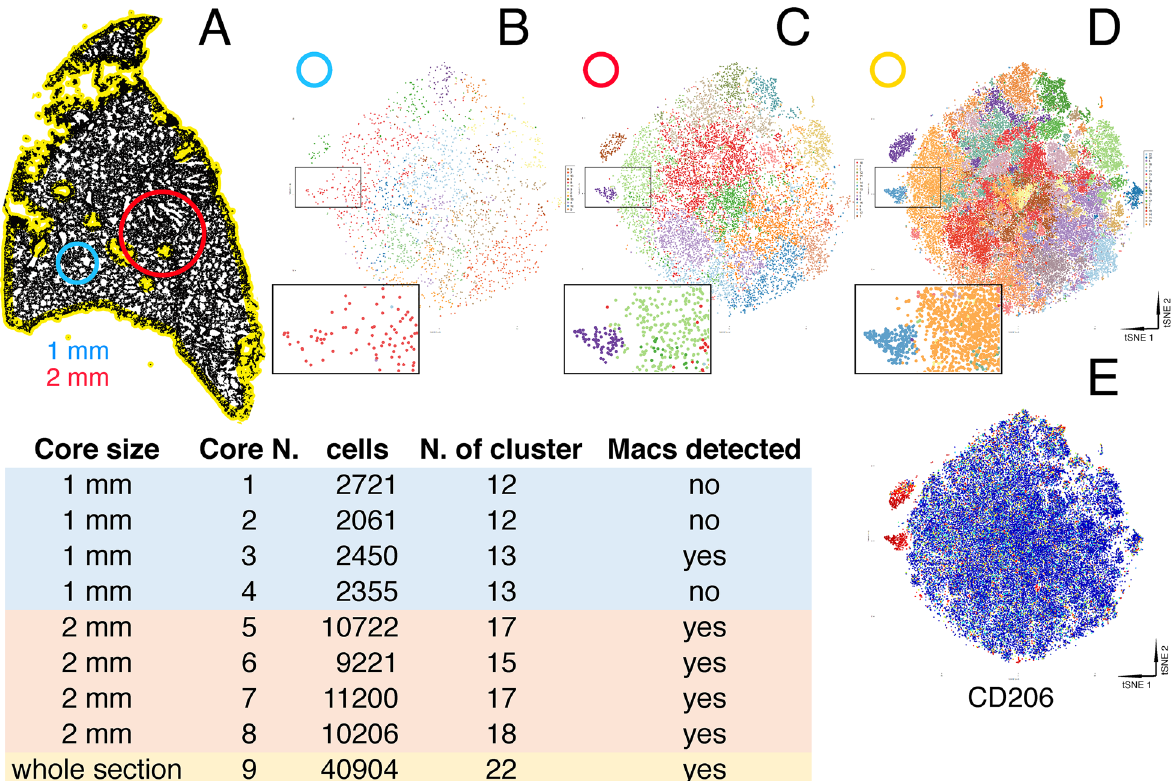
Figure 1. Core dimension validation for TMA construction. Representative DAPI-stained normal lung whole slide image ( A ) in which 1 (blue) and 2 (red) mm diameter representative cores are drawn. ( B – D ) tSNE plots derived from the 1 mm ( B ), 2 mm ( C ) cores and the whole section ( D ), from which the phenogroups have been extracted and plotted onto the tSNE plot. A detail of the plot is magnified at the bottom left of each. Note